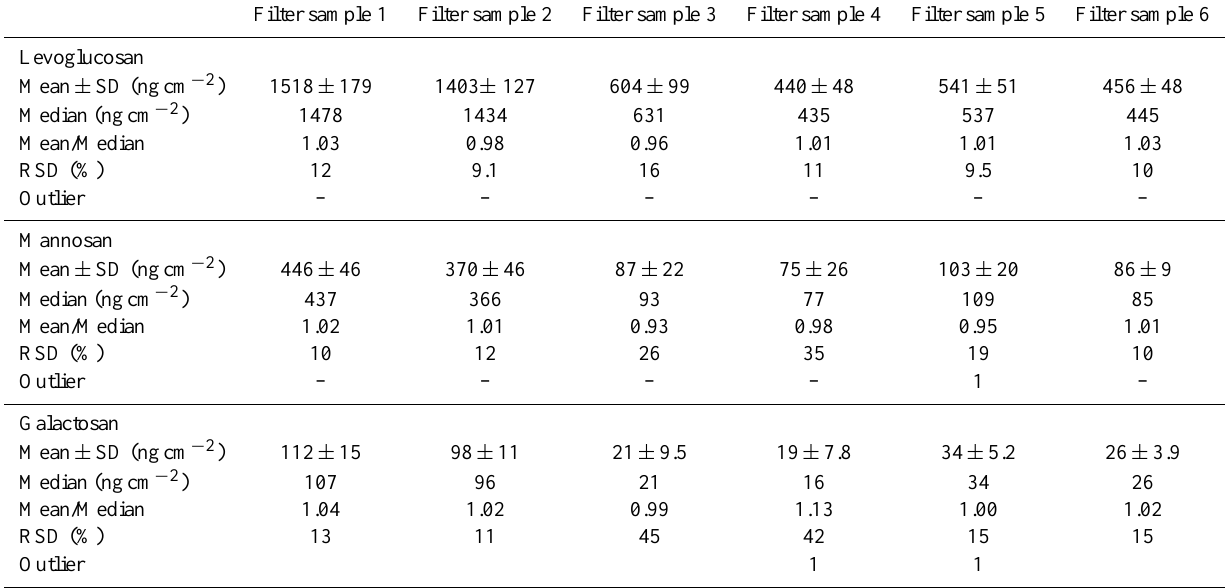
Table B2. Results of the homogeneity test of the six filter samples subjected to the present intercomparison. The results were obtained from one 1.0 cm2 punch taken from each of the 16 sectors per filter; i.e. a total of 96 analyses were performed for each of the three isomers. The filter samples were analyzed according to the method described in Sect.